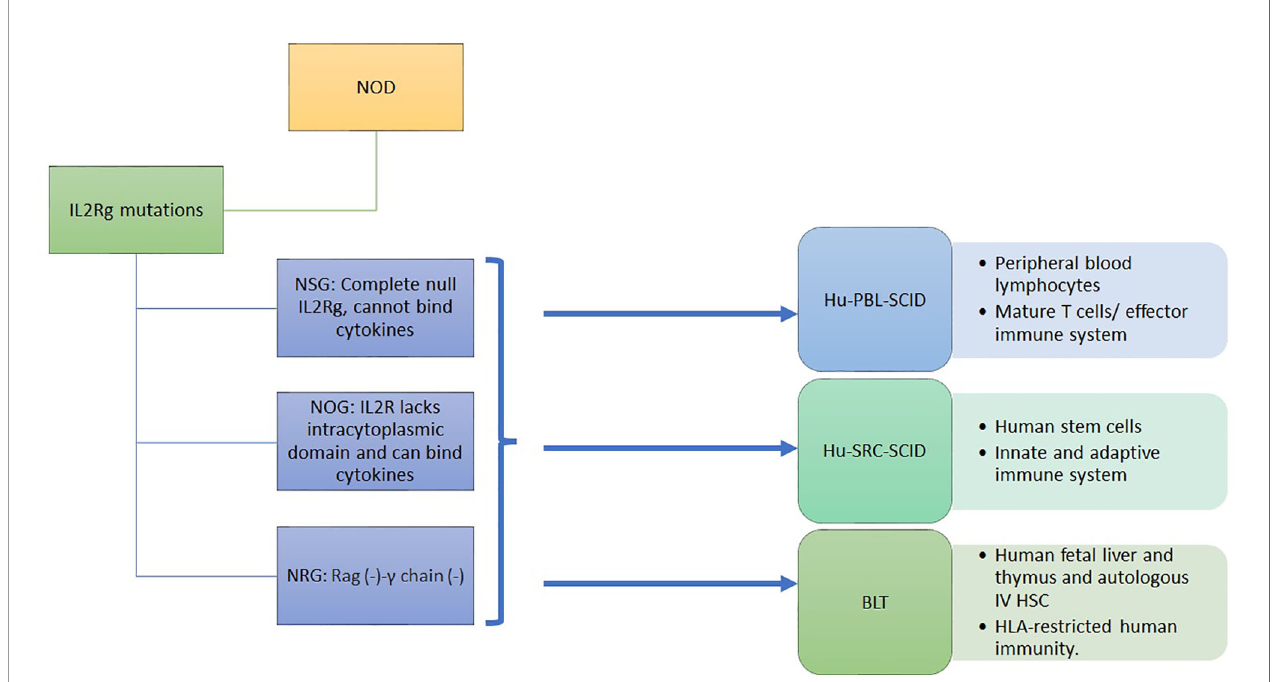
FIGURE 1 | Immunode fi cient humanized mice model with functional human immune